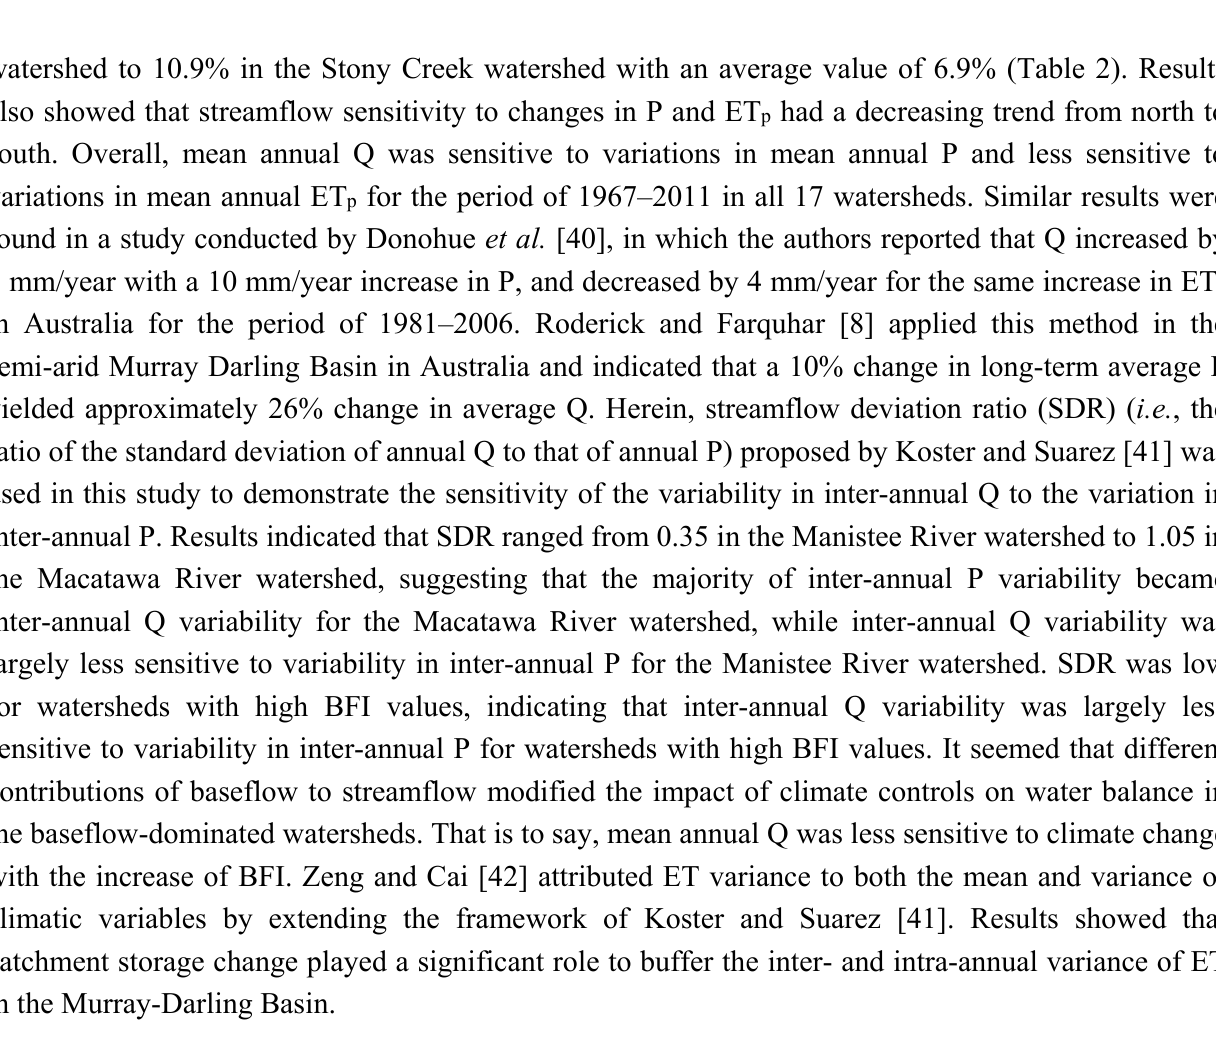
Table 2. Sensitivity of mean annual Q to variations in mean annual P and ET p in the study watersheds in